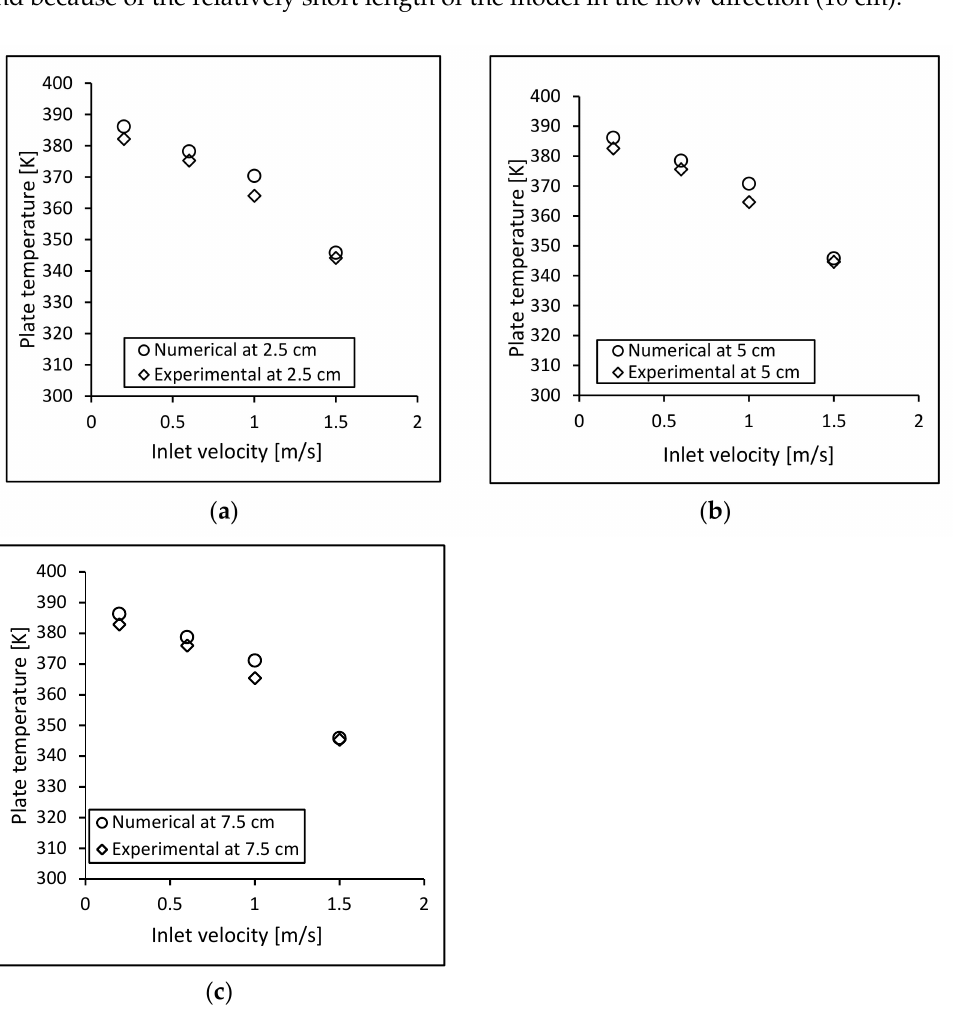
Figure 11. Comparison between experimental and numerical results for internal plate 2 at ( a ) 2.5 cm; ( b ) 5.0 cm; ( c ) 7.5 cm from the inlet.